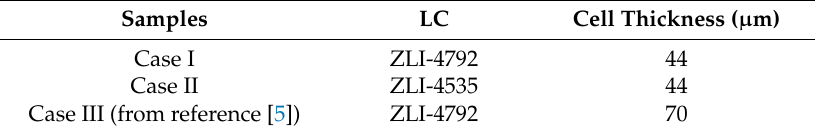
Table 1. Prepared test cells.